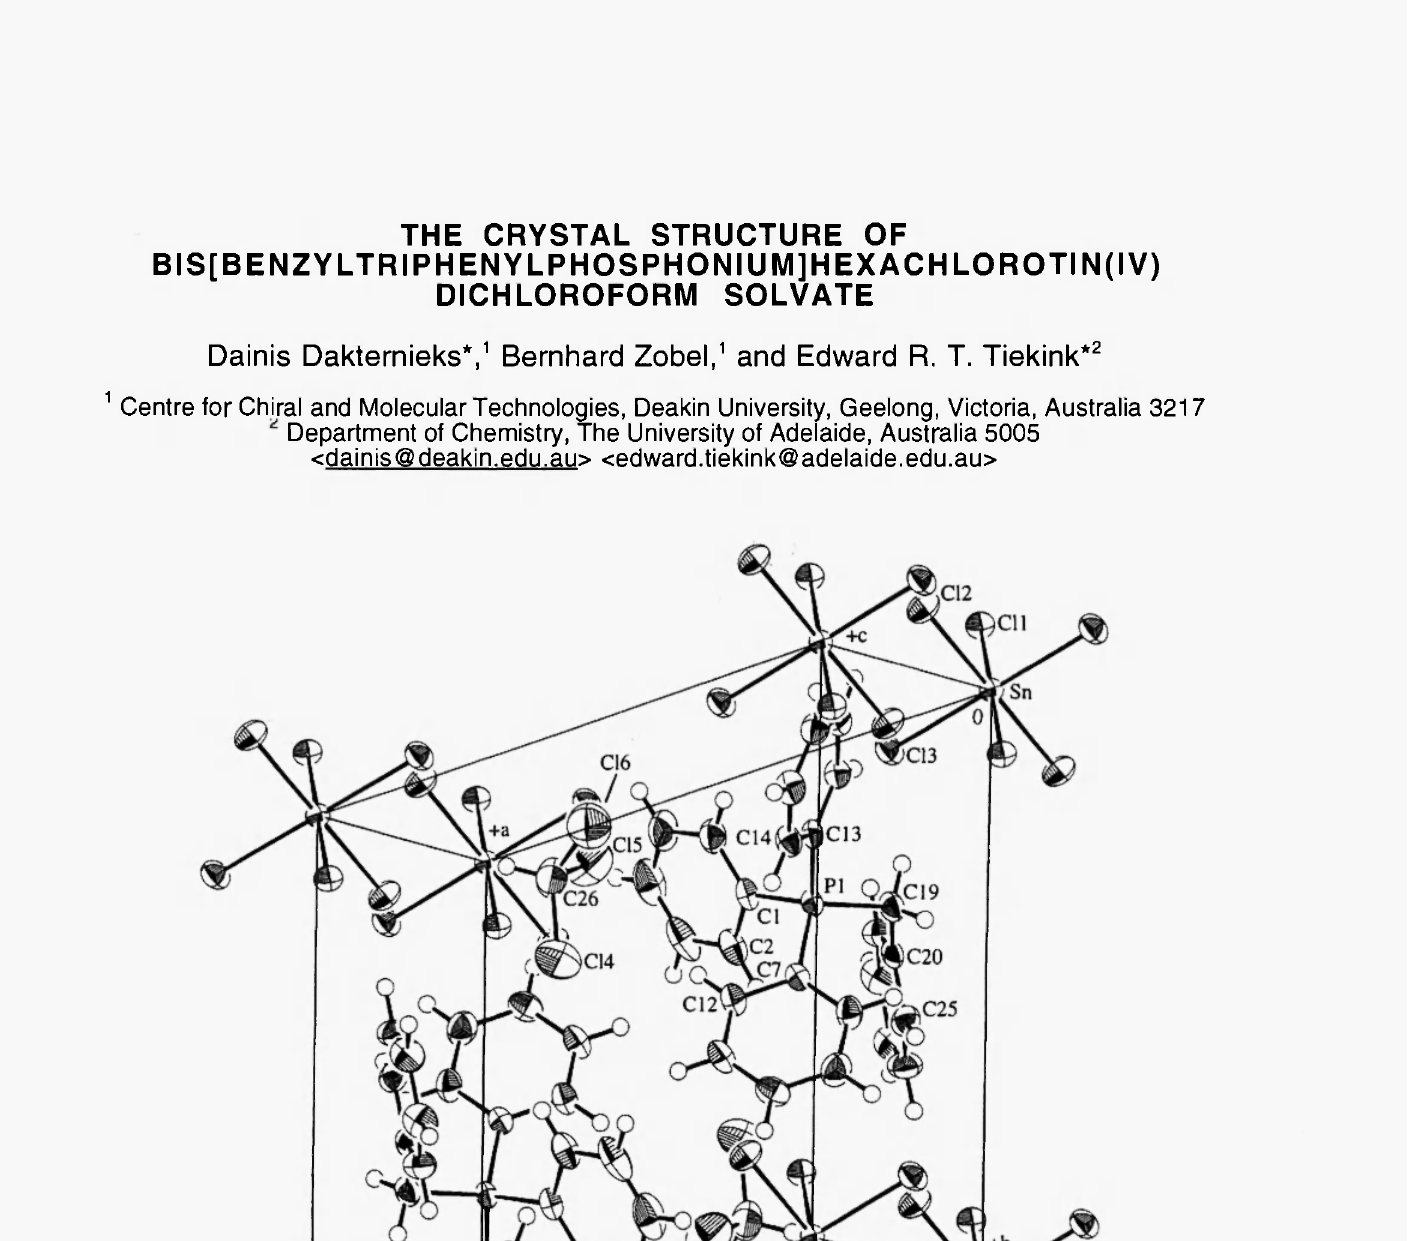
Figure 1. Unit cell contents and atomic labeling scheme for [(PhCH 2 )Ph 3 P] 2 [SnCI 6 ].2CHCl3 (50% probability ellipsoids). Selected bond distances and angles: Sn-CI(1) 2.436(1), Sn-CI(2) 2.424(1), Sn-CI(3) 2.441(1) A; Cl(1 )-Sn-CI(2) 90.72(4), Cl(1 )-Sn-CI(2)' 89.28(4), CI(1)-Sn-CI(3) 89.29(4), Cl(1)- Sn-CI(3)' 90.71(4), CI(2)-Sn-CI(3) 89.28(5), CI(2)-Sn-CI(3) i 90.72(5)°; symmetry operation /': -x, -y,